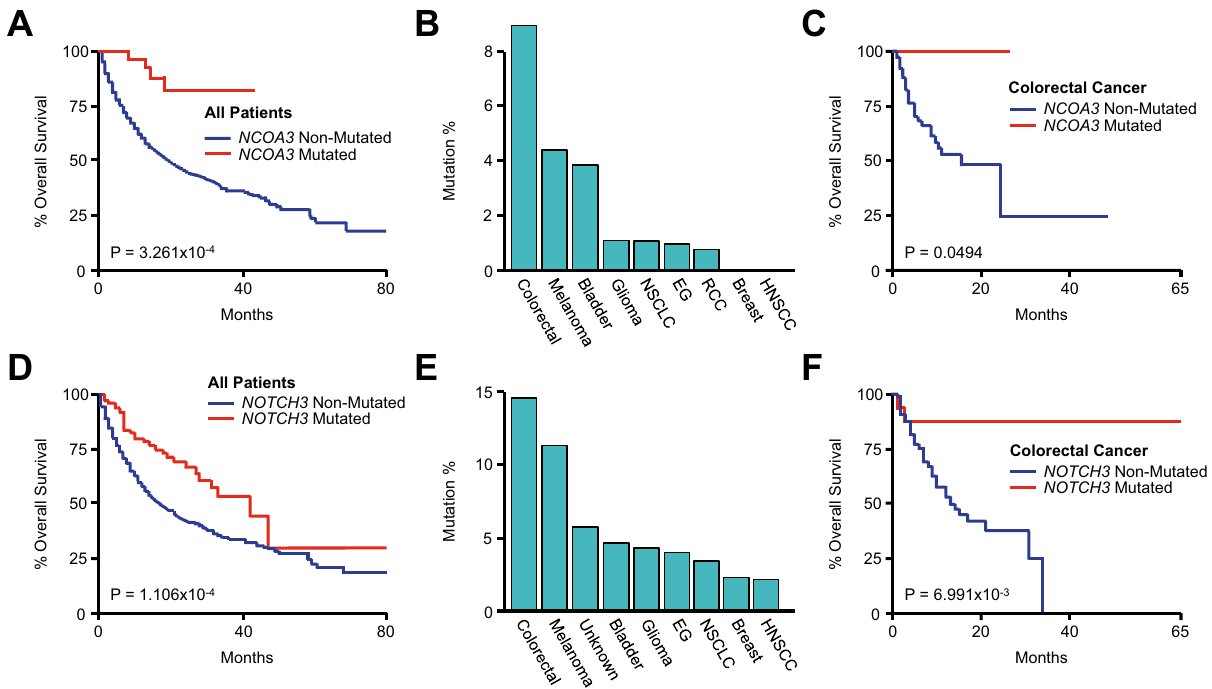
Figure 6. NCOA3 and NOTCH3 mutations are associated with improved survival in colorectal cancer patients receiving immune checkpoint inhibitors. ( A ) Kaplan Meier plot showing overall survival for the pan-cancer cohort (N = 1661) arranged by NCOA3 mutation status (33 NCOA3 -mutated and 1369 NCOA3 -non-mutated patients. An additional 259 NCOA3 -unprofiled patients were excluded from analysis). ( B ) The percent of NCOA3 -mutated patients arranged by tumor type. ( C ) Overall survival for the colorectal cancer cohort arranged by NCOA3 mutation status (N = 110, 8 NCOA3 -mutated, 102 NCOA3 -non-mutated patients). ( D ) Kaplan Meier plot showing overall survival for the combined pan-cancer cohort arranged by NOTCH3 mutation status (96 NOTCH3 -mutated and 1565 NOTCH3 -non-mutated patients). ( E ) The percent of NOTCH3 -mutated patients arranged by tumor type. ( F ) Overall survival for the colorectal cancer cohort arranged by NOTCH3 mutation status (16 NOTCH3 -mutated and 94 NOTCH3 -non-mutated